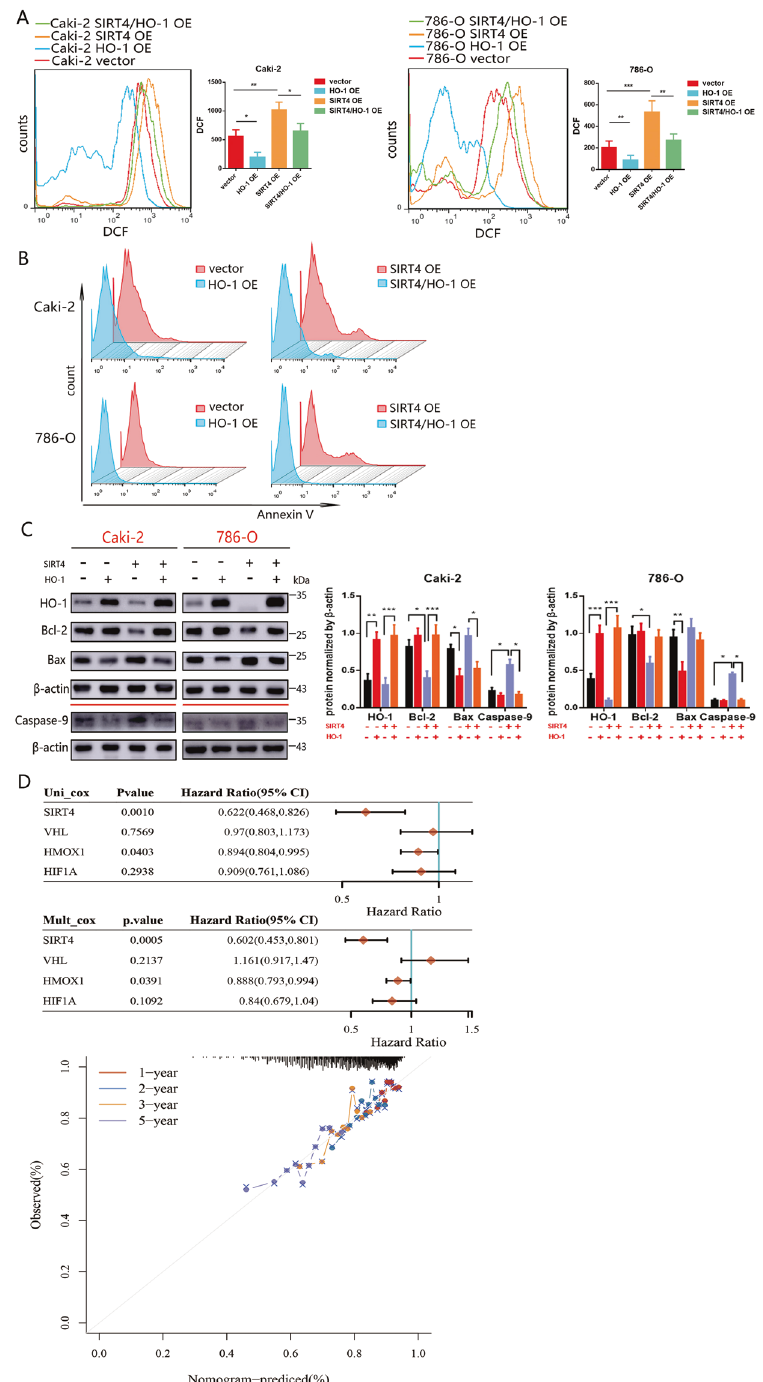
Fig. 7 SIRT4 and HO-1 were signi fi cant effectors for ccRCC prognosis. A The effect of HO-1 overexpression on intracellular ROS levels in Caki-2 and 786-O cells were measured by DCFH-DA fl uorescence. The quanti fi cation analysis (right panel) is shown. B The effect of HO-1 overexpression on apoptosis was analyzed by FACS. C Protein expression levels of apoptosis-associated genes after SIRT4 or HO-1 overexpression in 786-O and Caki-2 cells. The quanti fi cation analysis (right panel) is shown. D Hazard ratio and P value of constituents involved in univariate and multivariate Cox regression and some parameters of the SIRT4, VHL, HMOX1 (HO-1), and HIF1A (HIF-1 α ). Nomogram to predict the 1-, 2-, 3-, and 5-year overall survival of ccRCC cancer patients. A dashed diagonal line represents the ideal nomogram. ability of ccRCC cells [37]. SIRT4 also exerts a tumor-suppressive expression of SIRT4 reduced in cancerous tissues, and it was role by prompting abnormal cells to spontaneous death. More- associated with malignancies stage and grade. These data were over, SIRT4 responds to metabolic stress by regulating mitochon- consistent with the observation that SIRT4 might be a novel drial ROS production. Whereas the association between SIRT4 and biomarker for ccRCC [36, 37]. As reported, SIRT4 acts as a tumor ROS was omnifarious in different diseases. A recent study suppressor by repressing proliferation, migration, and invasion Cell Death and Disease (2021)